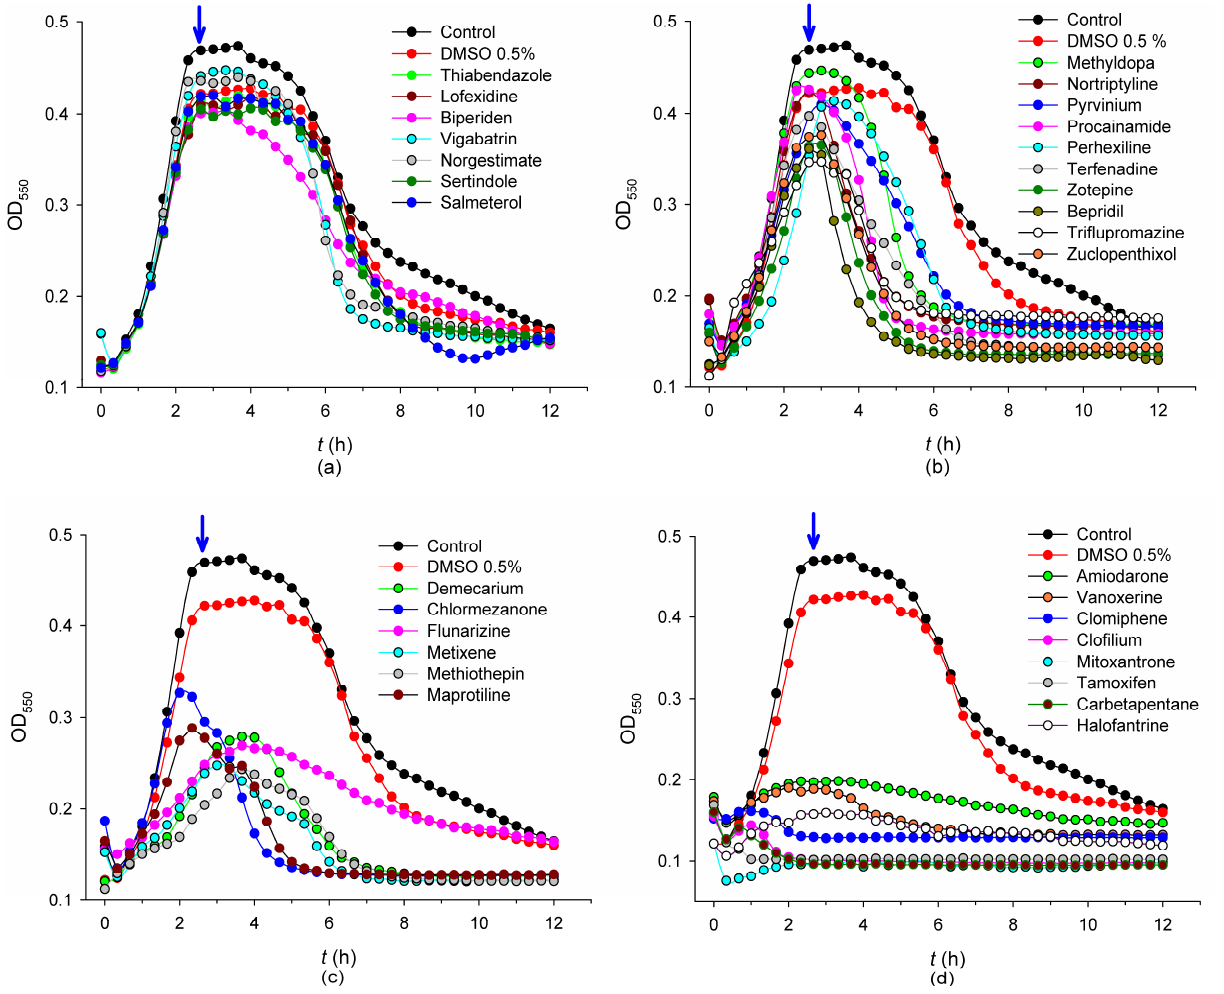
Figure 2. Effect of 31 selected compounds (25 µM) (Table 1) on pneumococcal planktonic growth. Arrows indicate the time of removal of samples for the viability assays (Table 1): ( a ) no significant effect; ( b ) weak effect; ( c ) notable effect; ( d ) strong effect.